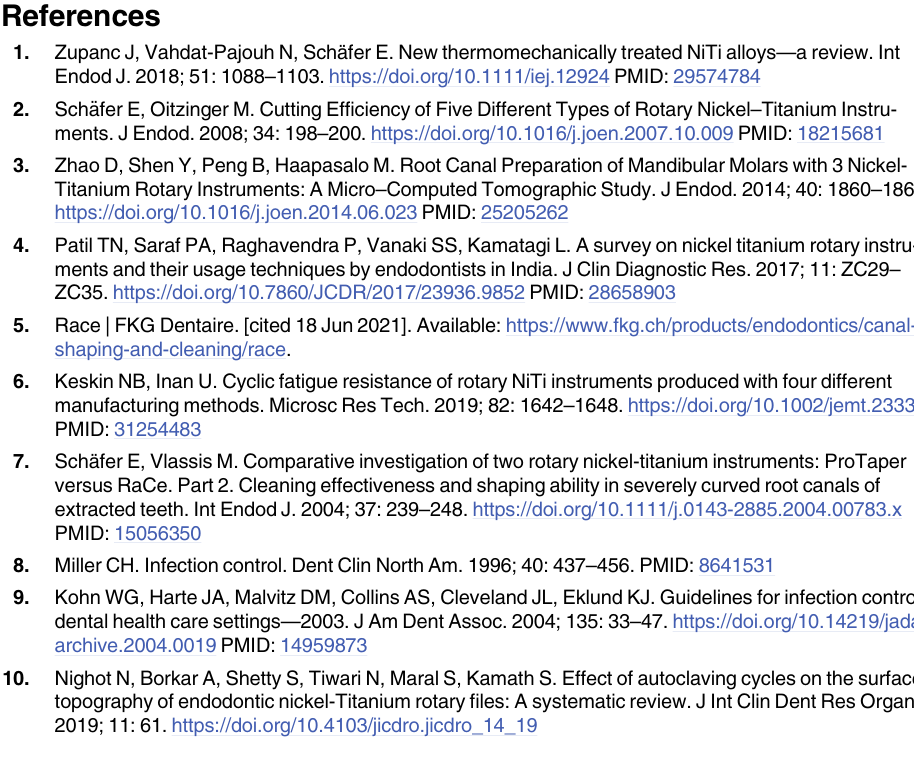
S1 Table. Detailed dataset for all surface roughness parameters for both Race and Race Evo files as seen under two magnifications x450 and